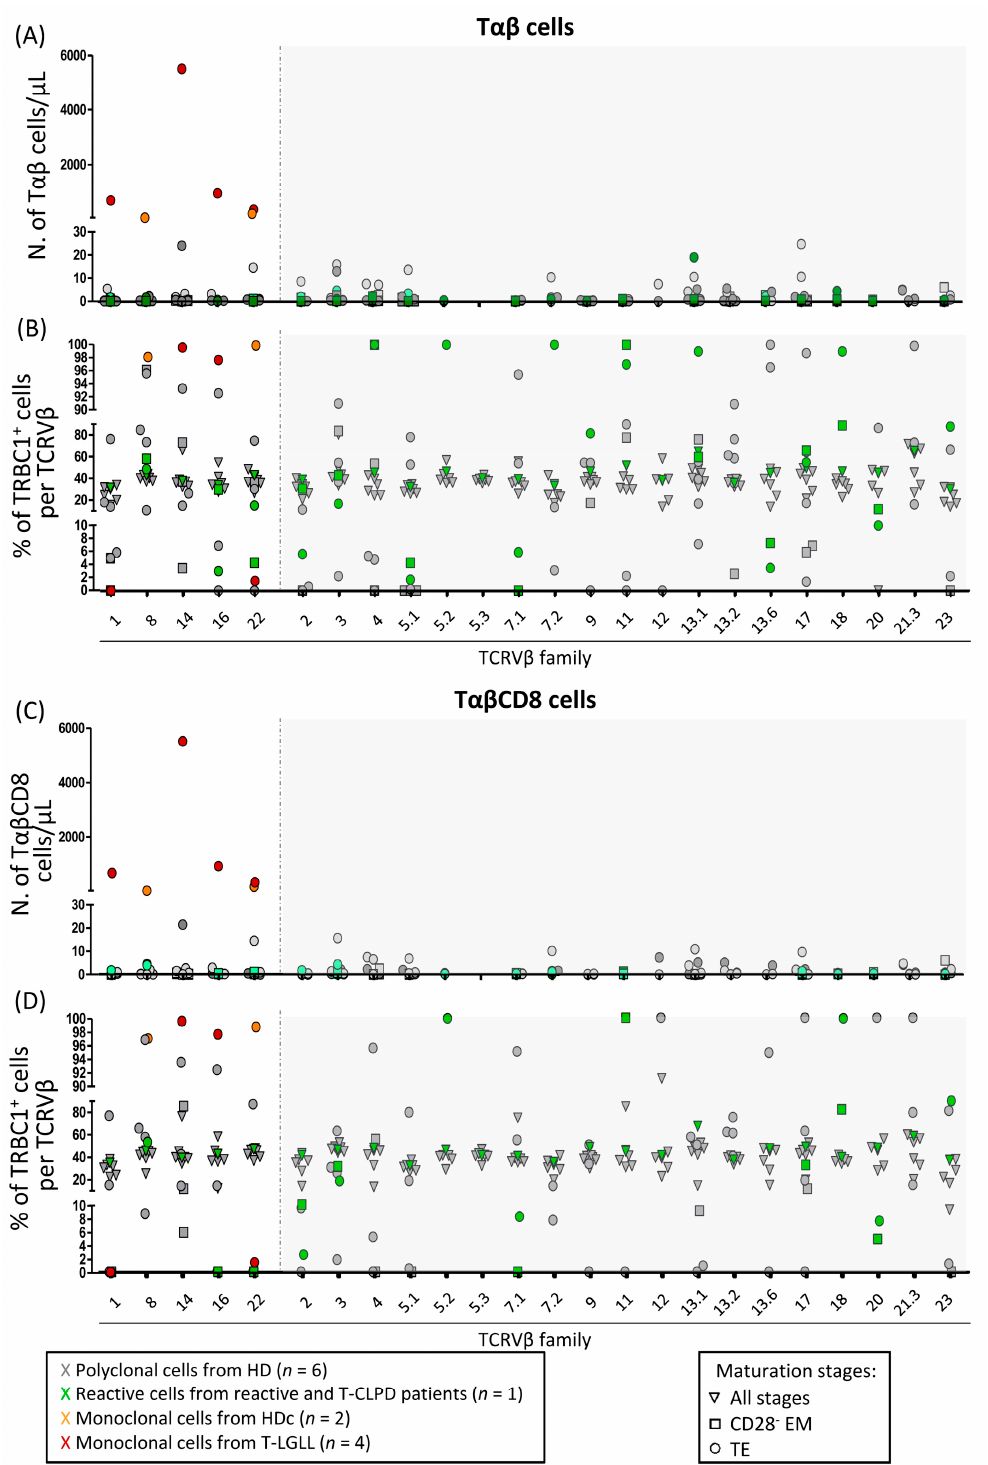
Figure 2. Absolute counts and relative distribution of TRBC1 + cells per TCRV β family, among the more mature subsets (CD28 − EM and TE) of normal ( n = 6) and reactive ( n = 1) polyclonal T αβ -cells vs. clonal T αβ -LGL ( n = 2 HDc and n = 4 LGLL). Absolute number ( A , C ) and percentage ( B , D ) of TRBC1 + cells within each TCRV β family among total T αβ cells ( A , B ) and their major T αβ CD8 subset ( C , D ). Abbreviations (alphabetical order): EM, effector memory; HD, healthy donor; HDc, healthy donor with a T-LGL clone; N., number; T-CLPD, chronic lymphoproliferative disorder of T cells; T-LGLL, T-cell large granular lymphocytic leukemia; TE, terminal effector.